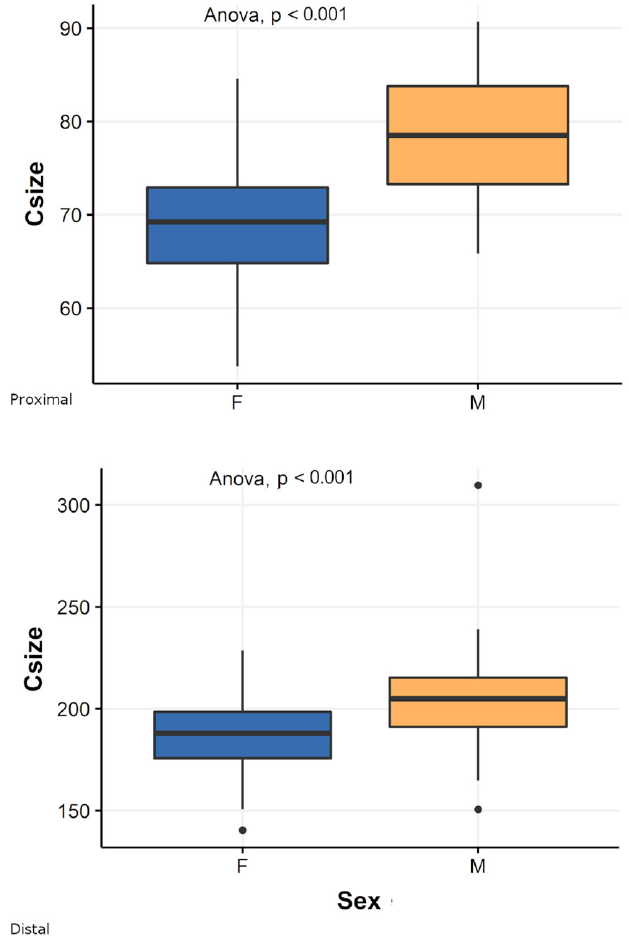
Figure 4. Box plot of centroid size (Csize) of proximal ( above ) and distal ( below ) fibular epiphyses for the pooled sample by sex. M = males; F = females. Black lines are the medians, boxes represent the interquartile ranges, whiskers the non-outliers range and filled circles the outliers. Table 4. Sex determination accuracy percentages obtained by cross-validation LDA on the pooled sample (Emilia-Romagna, Sardinia, and South Africa) for shape and form PC scores (PCs) and centroid size (CS) of proximal and distal